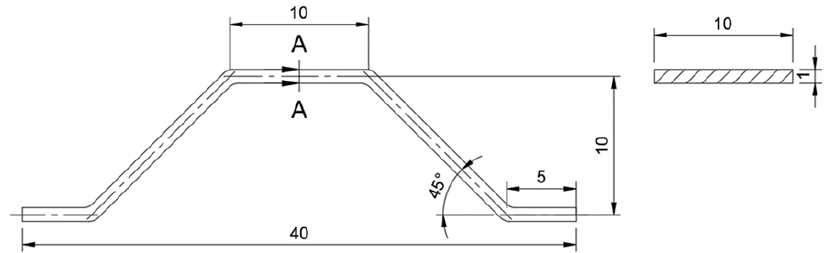
Figure 10. Navtruss Core Strutt Geometry. (Dimensions in mm).